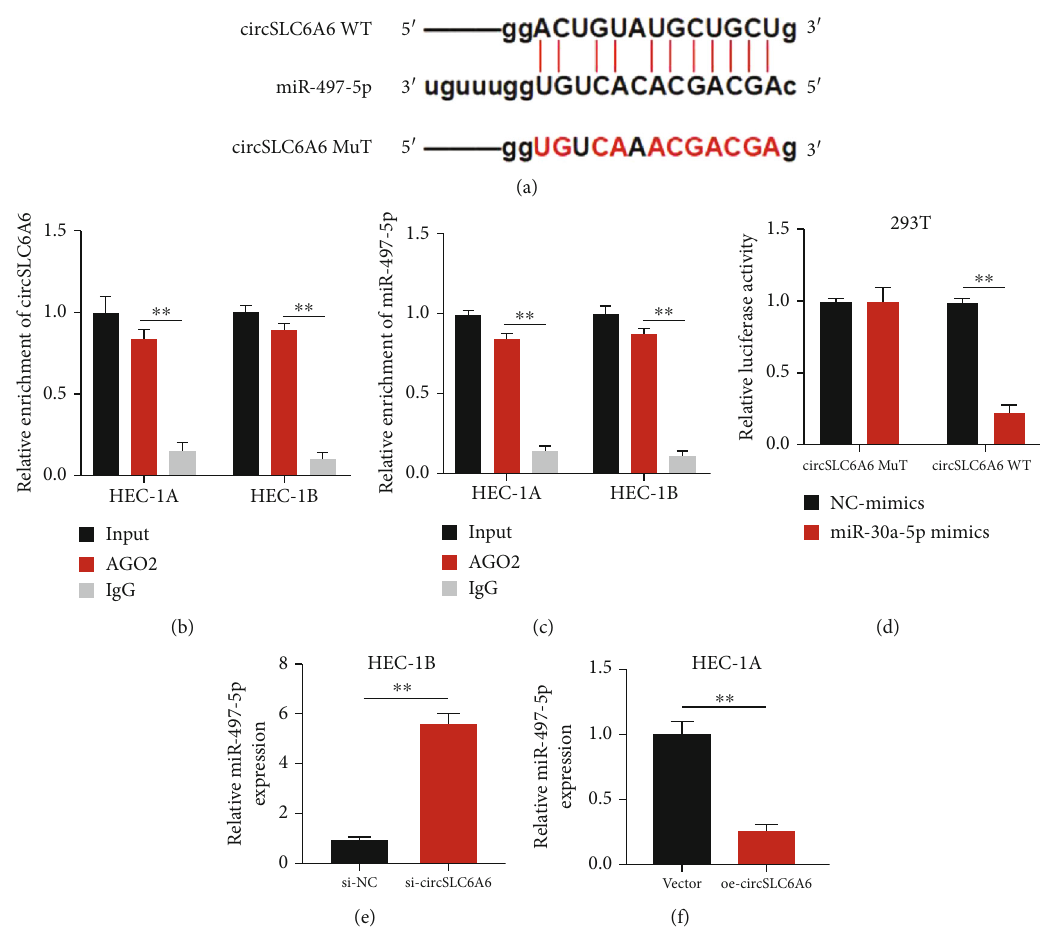
Figure 3: circSLC6A6 serves as an e ffi cient miR-497-5p sponge in EC. (a) The putative binding sites between circSLC6A6 WT/MuT and miR- 497-5p. (b, c) RIP experiments with the AGO2 antibody were conducted to detect the expression of circSLC6A6 and miR-497-5p in HEC-1A and HEC-1B cells. (d) Luciferase activity was detected in luciferase reporter vectors harboring circSLC6A6 WT/MuT sequences and miR-497- 5p mimic-/NC mimic-cotransfected 293T cells. (e, f) The expression of miR-497-5p in HEC-1B cells transfected with si-circSLC6A6 and HEC-1A cells transfected with oe-circSLC6A6 was detected using the qRT-PCR assay ( ∗∗ p < 0 : 01